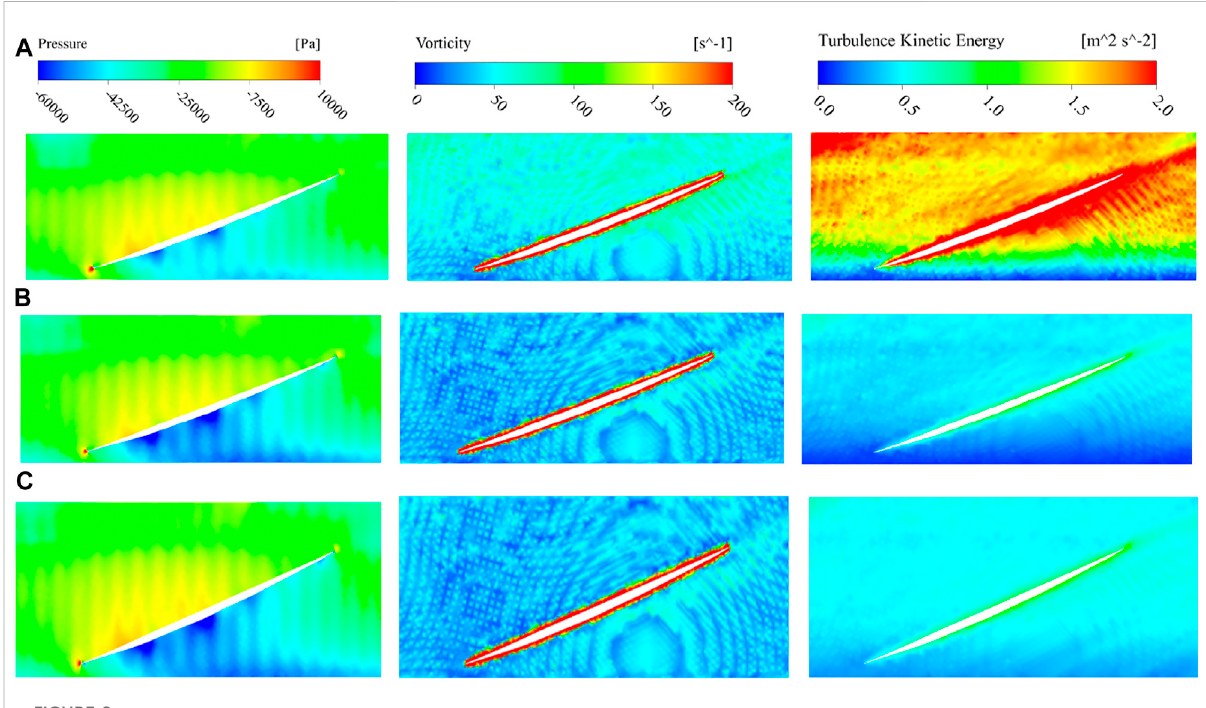
FIGURE 8 Distributions of pressure, vorticity, and turbulent kinetic energy (TKE) near the tip region ( R * = 0.95): (A) IR pump, (B) GVR pump, and (C) CR pump.